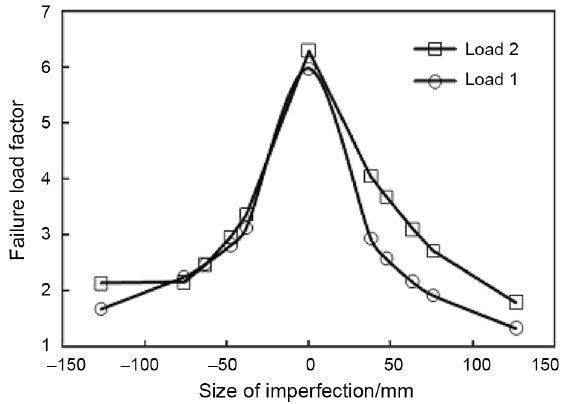
Fig. 11. Imperfection